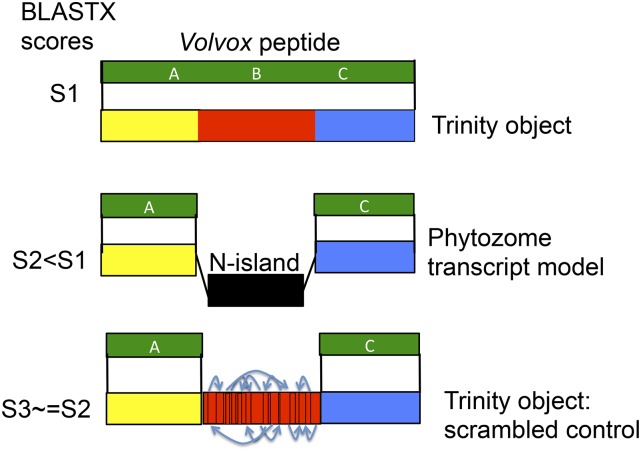
Authentic missing exons can encode evolutionarily conserved sequence: the Volvox BLASTX test. Assume that a Trinity object, but not the most closely related Phytozome transcript model, contains a hidden exon (Figure 1). Volvox is a close relative to Chlamydomonas. If BLASTX of the Trinity object against Volvox gives a score, S1, due to alignment to segments A, B, and C, then BLASTX of the corresponding best-hit Phytozome model (A–C) will give a score S2 < S1, due to lacking alignment from the middle segment lost in the N-island. As a control, scrambling the intervening sequence from the Trinity object (random permutation of the amino acid sequence) should eliminate any scoring advantage, yielding score S3 ≈ S2 < S1.